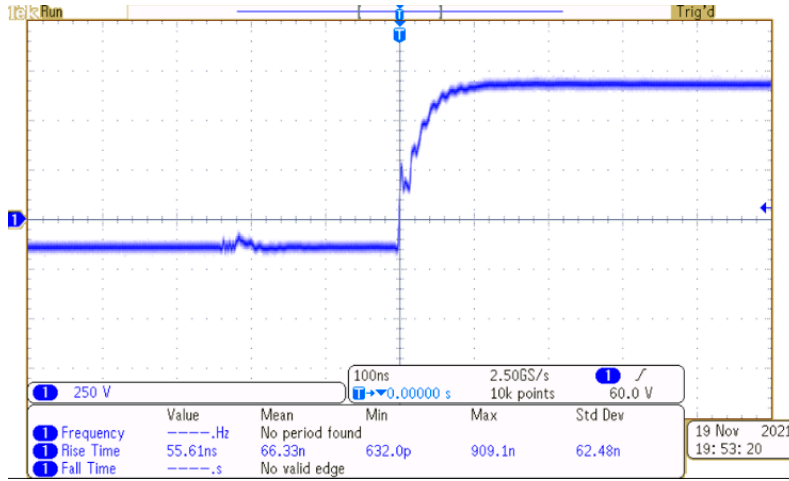
Figure 12. Gate—source voltage rise time for transistor SiC v3 (129 ns).